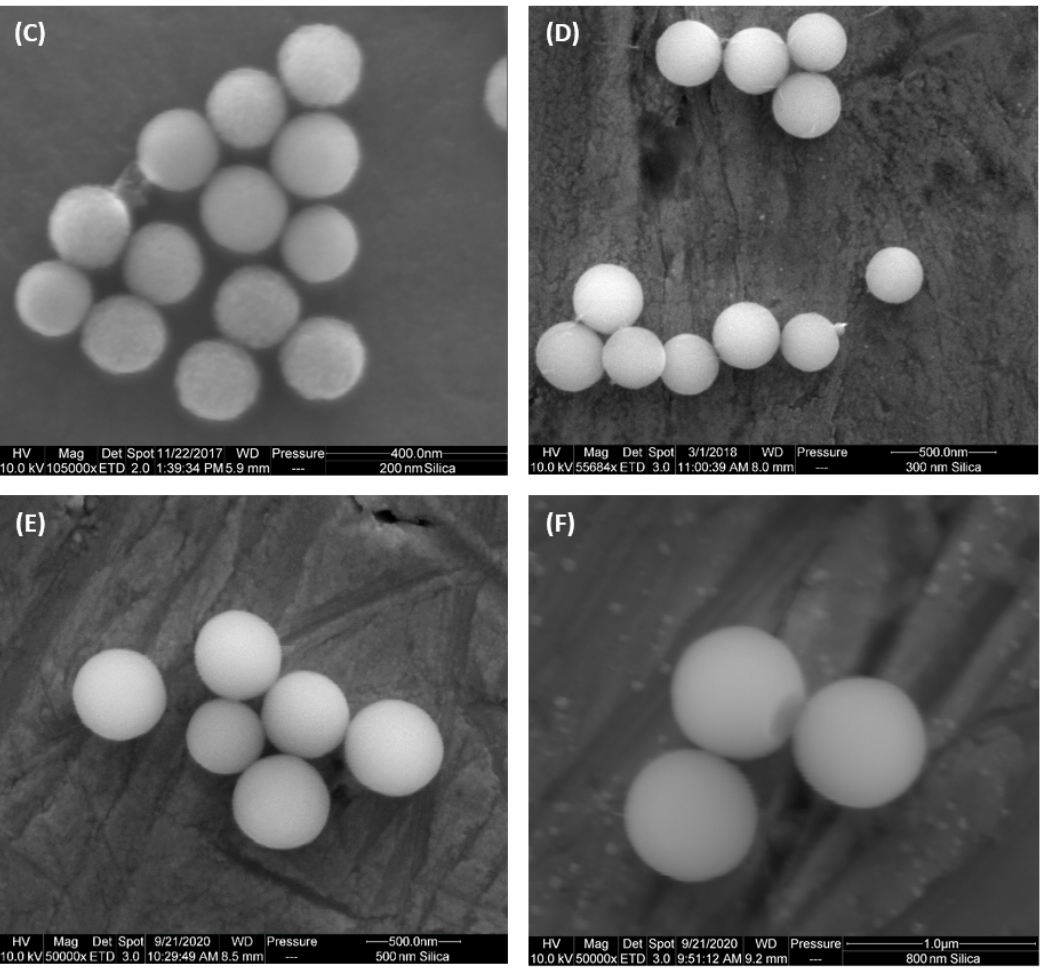
Figure A1. SEM images of the measured silica nanoparticle samples of different sizes. ( A ) 70 nm silica nanoparticles, ( B ) 100 nm silica nanoparticles, ( C ) 200 nm silica nanoparticles, ( D ) 300 nm silica